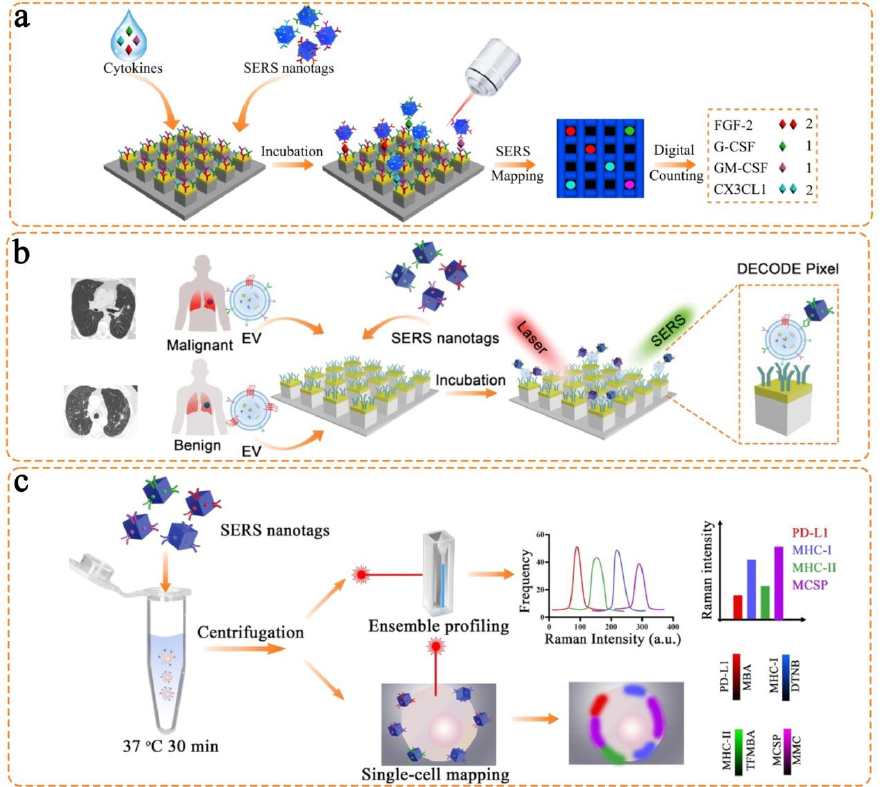
Figure 7. Gold–silver alloy nanobox-based SERS nanotags for a variety of cancer biomarker detection. ( a ) The integration with the nanopillar array for digital counting of four cytokines (i.e., FGF-2, G-CSF, GM-CSF, and CX3CL1). Reproduced with permission [55]. Copyright 2021, Nature Publishing Group. ( b ) Digital assay to measure four lung cancer-associated EV biomarkers for differentiating malignant and benign lung cancers. Reproduced with permission [56]. Copyright 2022, Wiley-VCH. ( c ) Profiling of four biomarkers on melanoma CTCs (i.e., PD-L1, MHC-I, MHC-II, and MCSP). Reproduced with permission [57]. Copyright 2022, American Chemical Society.